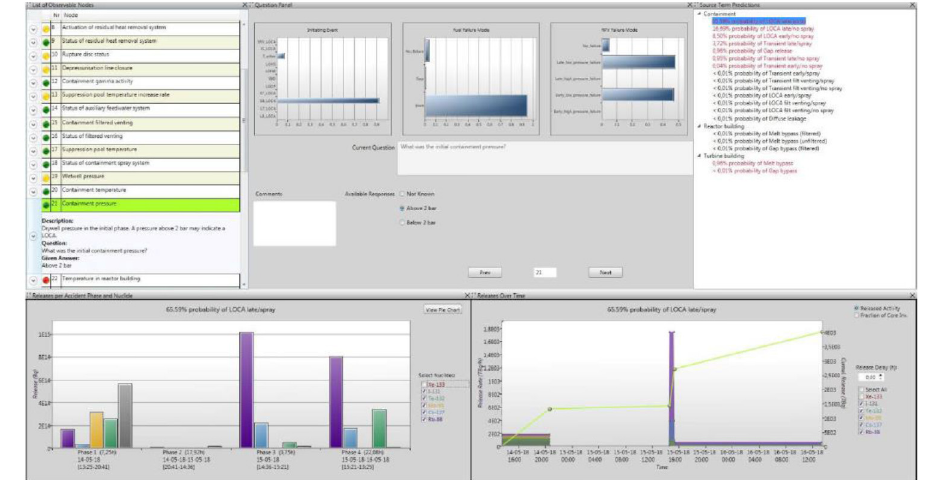
Fig. 4. RASTEP Graphical